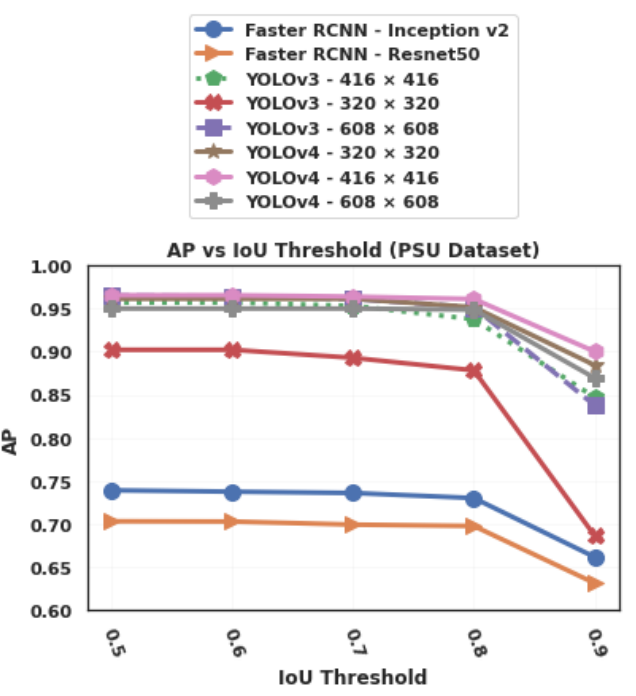
Figure 17. AP (Average Precision), at different IoU (Intersection over Union) threshold values, of the tested algorithms on the PSU (Prince Sultan University) dataset.